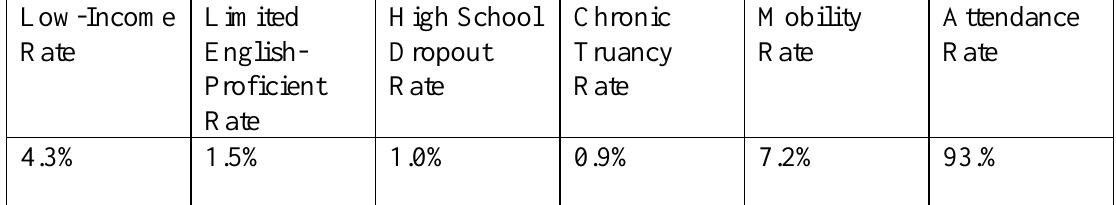
School District Characteristics and Percentages of Students for the High School